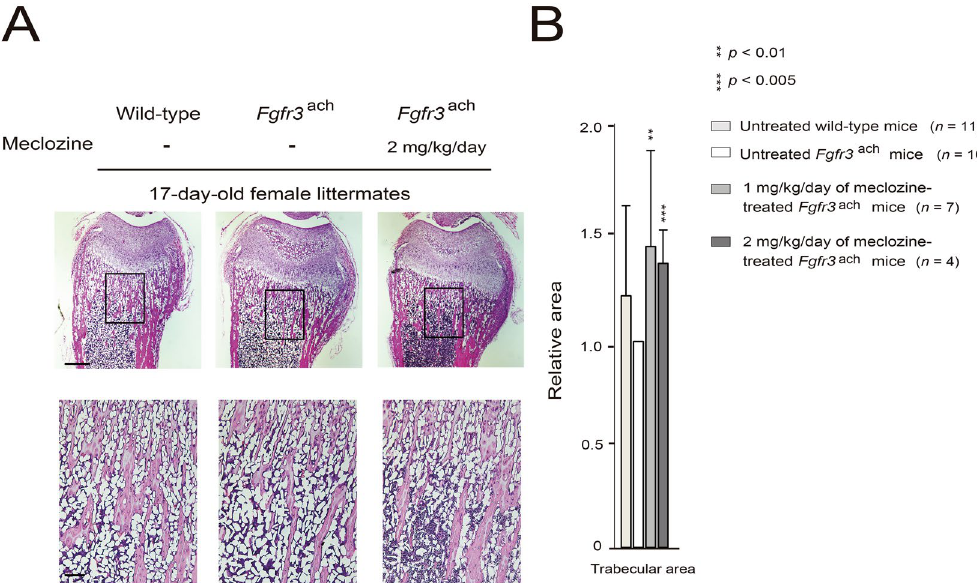
Figure 5. Administration of meclozine increases the trabecular bone area in the metaphysis of Fgfr3 ach mice. ( A ) Representative decalcified histology images of the distal femur stained with hematoxylin-eosin (HE) demonstrated that the trabecular bone was more abundant in 2 mg/kg/day of meclozine-treated Fgfr3 ach mouse than in untreated Fgfr3 ach mouse. Squared parts are magnified in lower panels. Scale bares indicate 400 μ m in upper panels and 100 μ m in lower panels. ( B ) Quantitative analyses of the trabecular area stained by HE showed that relative trabecular area was significantly increased by administration of 1 or 2 mg/kg/day of meclozine in Fgfr3 ach mice. Relative areas of the trabecular bones were calculated based on those of untreated Fgfr3 ach mice. Mean and SD are indicated. Statistical significance was analyzed by the unpaired t test for each dose of meclozine-treated Fgfr3 ach mice ( n = 7 and 4 for 1 and 2 mg/kg/day of meclozine, respectively) or untreated wild-type mice ( n = 11) versus untreated Fgfr3 ach mice ( n =